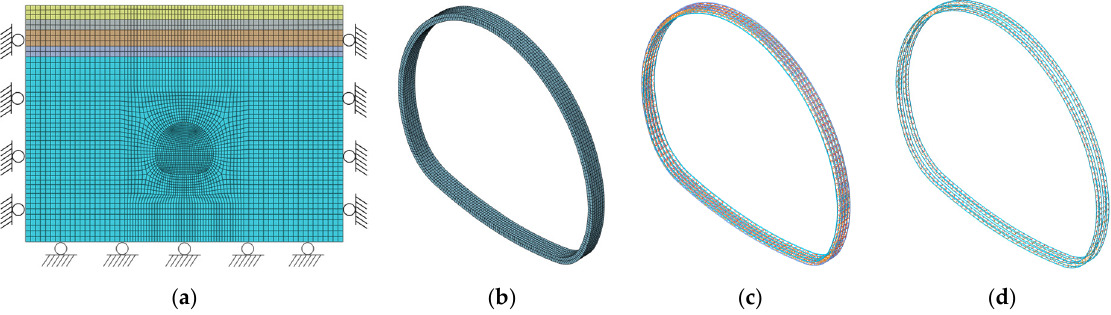
Figure 18. Finite element model meshing: ( a ) overall model, ( b ) shotcrete, ( c ) SRS arch, ( d ) grid arch. Table 3. Geotechnical parameters of the surrounding rock.